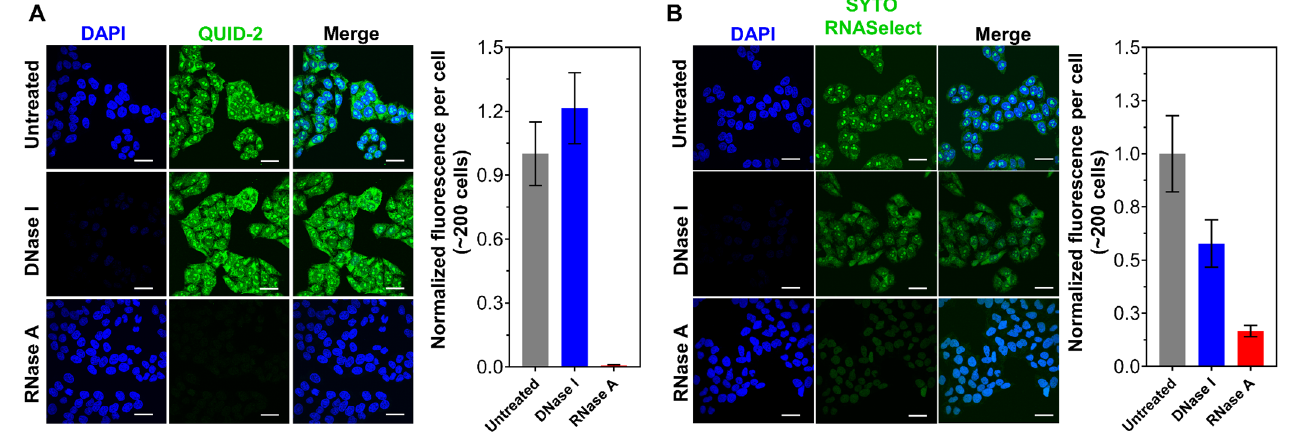
Figure 4. ( A ) Imaging of fixed HeLa cells stained with 0.5 μ M QUID − 2 ( λ ex = 488 nm, λ em = 500–600 nm, green) and treated by DNase I or RNase A. ( B ) Imaging of fixed HeLa cells stained with 0.5 μ M SYTO RNASelect ( λ ex = 488 nm, λ em = 500–600 nm, green) and treated by DNase I or RNase A. Quan- tification of the QUID − 2 and SYTO RNASelect fluorescence intensity is shown in the right panel. The nucleus was visualized by DAPI ( λ ex = 405 nm, λ em = 430–490 nm, blue). For each sample, ap- proximately 200 cells were measured, and the standard error was calculated from a set of three replicate experiments. Scale bars for cell image: 30 μ m.